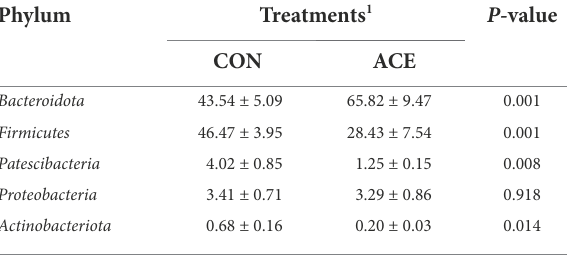
TABLE 5 Effects of dietary supplementation with NAc on the relative abundance of ruminal bacterial communities at genus level (average relative abundance ≥ 0.5% for at least one treatment) of dairy